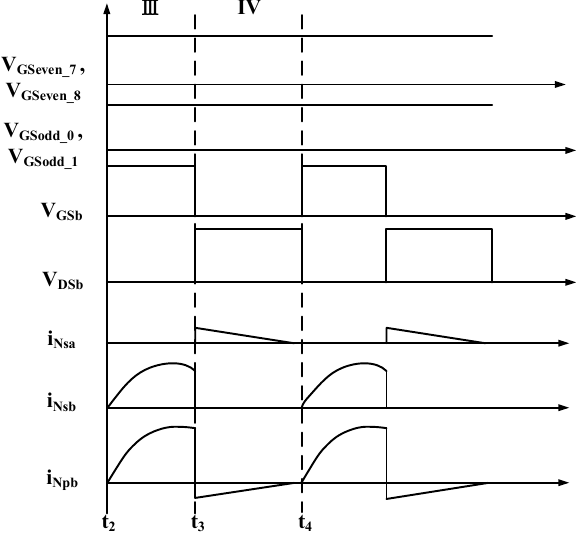
Figure 5. The theoretical waveforms in balancing process from V Bat8 to V Bat1 .